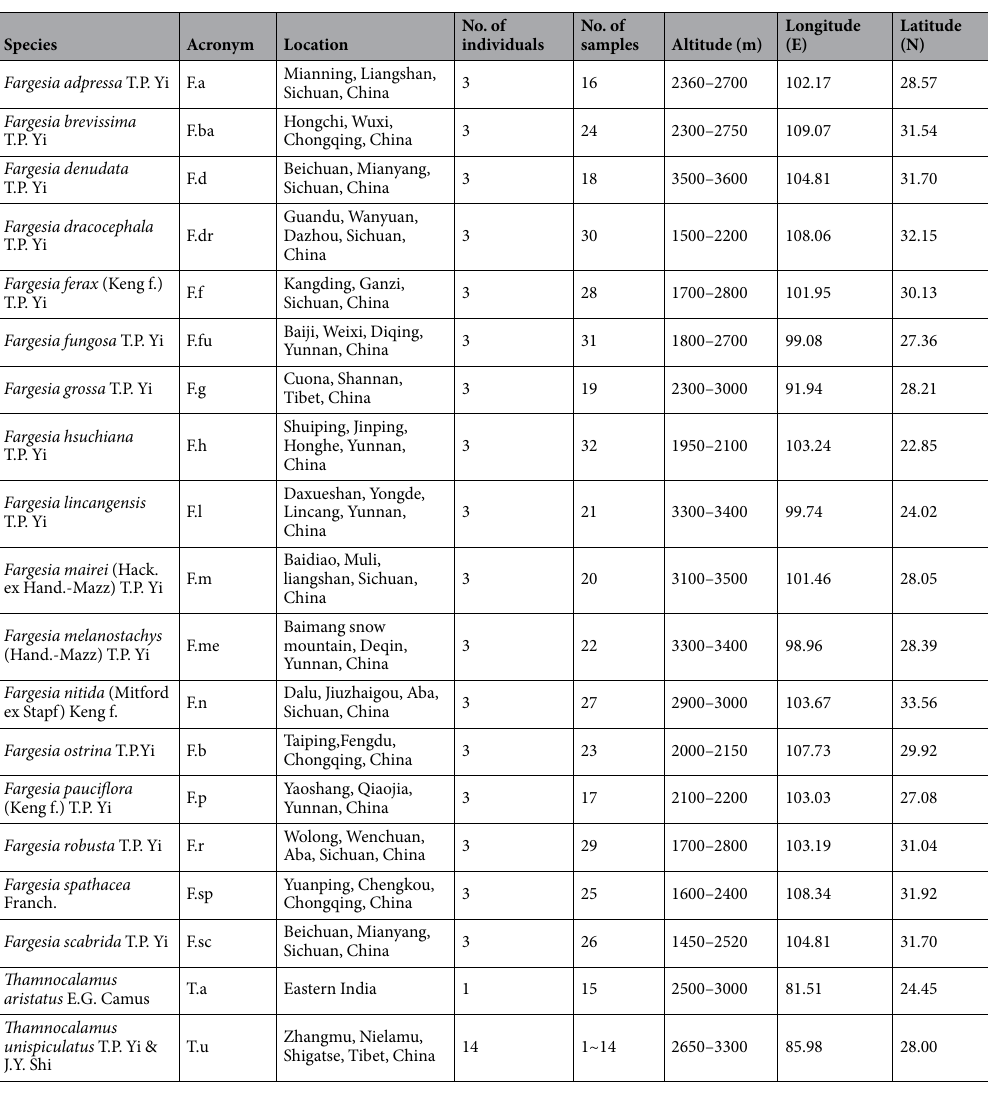
Table 1. Plant material used in the